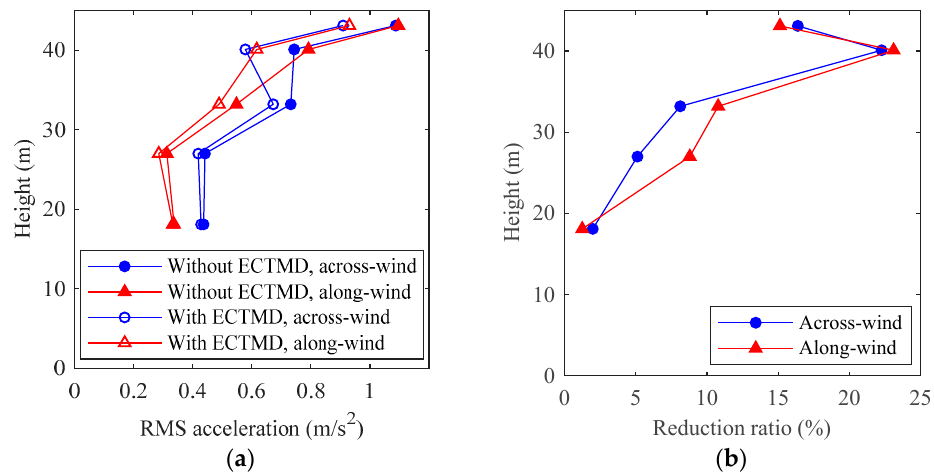
Figure 17. Acceleration responses and reduction ratios along height under wind speed of 24.7 m/s and wind direction angle of 0°. ( a ) Acceleration responses; ( b ) Reduction ratios.